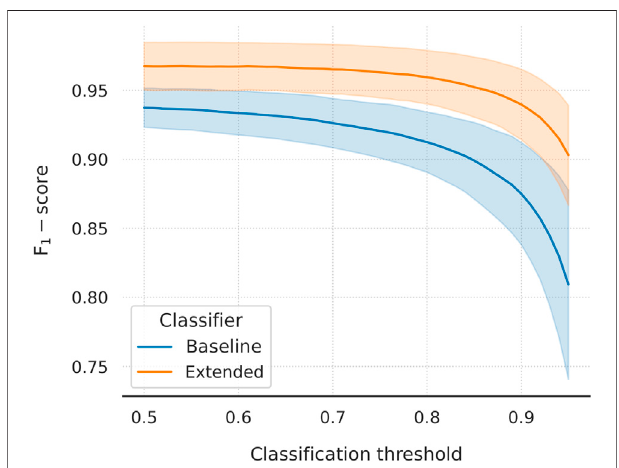
FIGURE 5 | Macro F 1 -score as a function of classi fi cation threshold varied in the domain [0.5, 0.95]. Mean values and standard deviations are plotted. The extended model outperforms the baseline at every threshold value. There is a clear difference in slope, with the baseline curve being steeperthroughoutthedomain.Learningfromtheexternalfeaturevectorshas pushed the extended classi fi er to be more con fi dent in its predictions. In turn, using the same threshold for both models will lead to (at least) one of them under-performing. A higher threshold is desirable, as it tends to improve the performance of the models on the more challenging second external